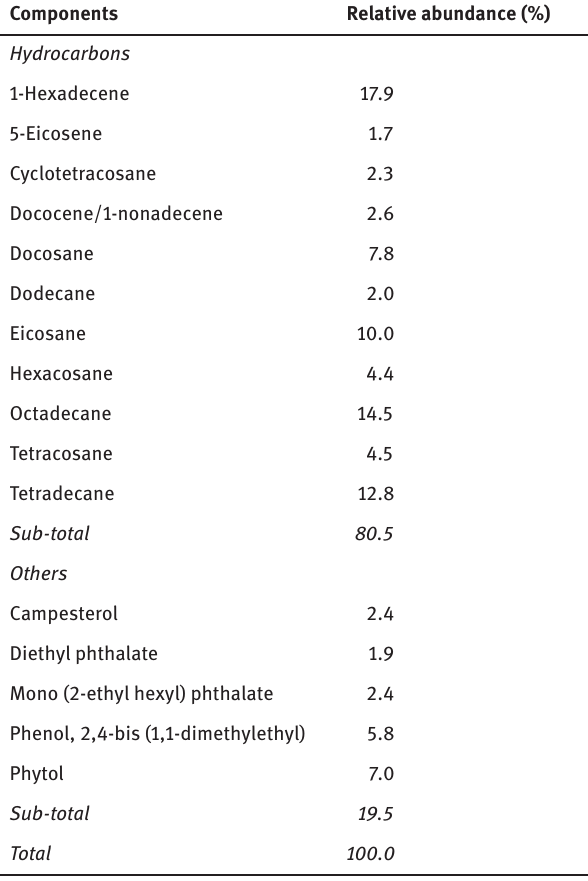
Table 3: GC-MS chemical characterization of the